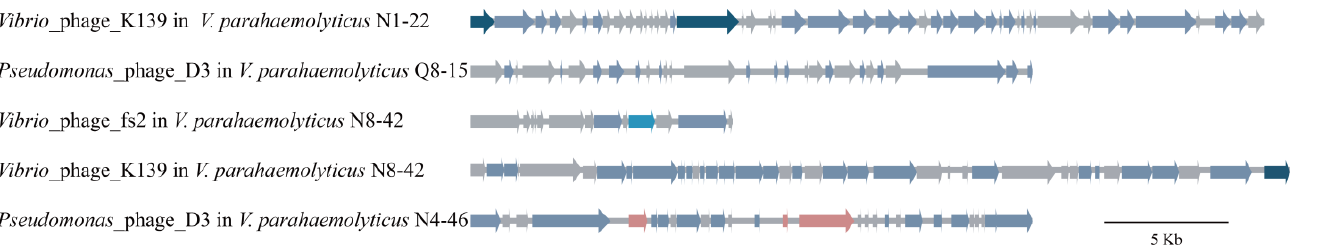
Figure 6. Structure diagram of the prophage gene clusters identified in the V. parahaemolyticus ge- nomes.